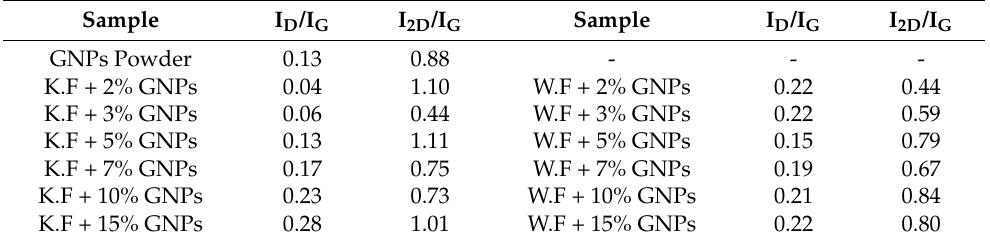
Table 3. I D /I G and I 2D /I G values for GNPs Powder and functionalised knitted and woven fabric with different GNPs %. Sample I D /I G I 2D /I